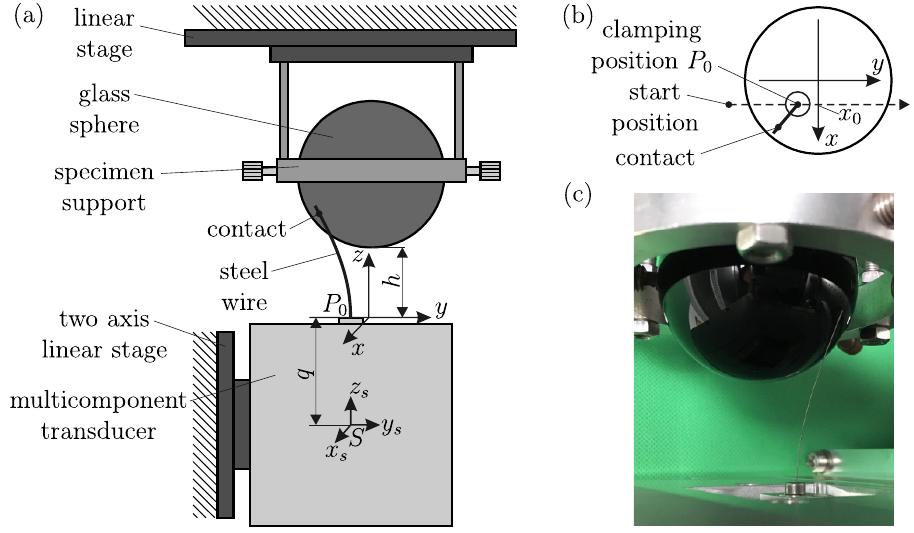
Figure 6. Experimental setup: ( a ) schematic representation of the experiment; ( b ) top view on ( a ); ( c ) one-sided clamped wire in tangential contact with a glass